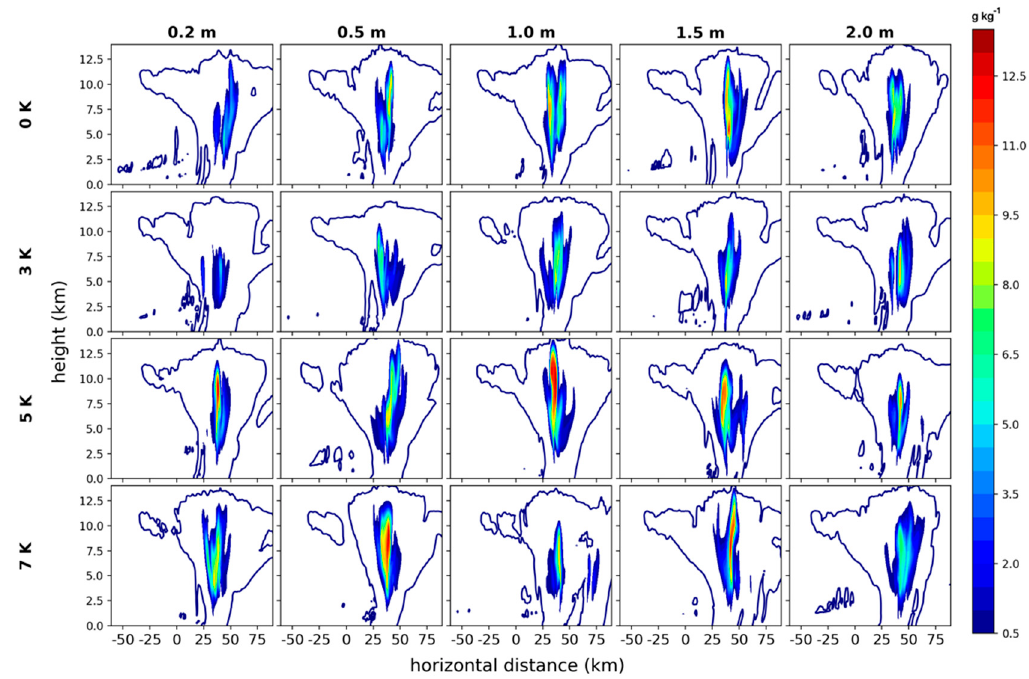
Figure 18. Vertical cross-sections of the graupel / hail mixing ratio at t = 190 min. The blue contour represents the hydrometeor mixing ratio of 0.02 g kg − 1 .